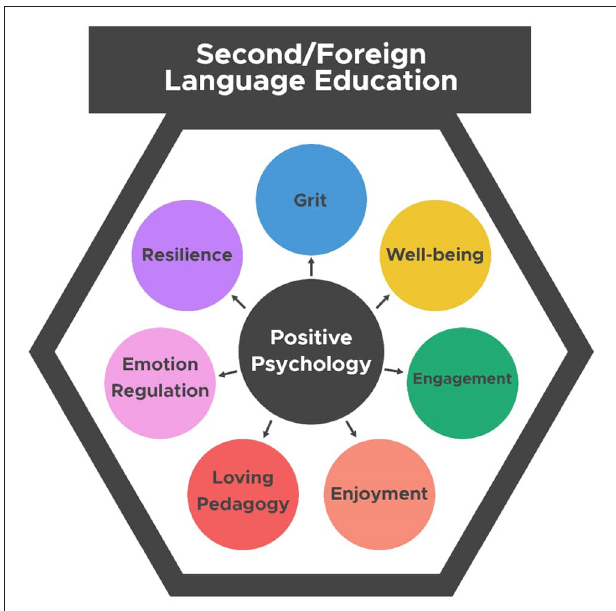
FIGURE 1 | Potential positive psychology factors contributing to the second/foreign language learning